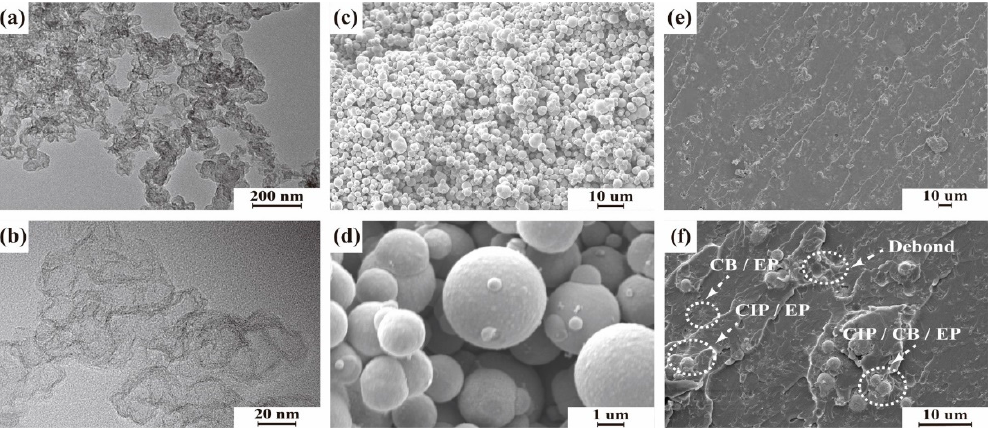
Figure 4. Morphologies of the composites. ( a , b ) TEM graphics of the CB powders; ( c , d ) SEM images of the CIP powders; ( e , f ) SEM images of the fracture surface of the CB/CIP/EP.